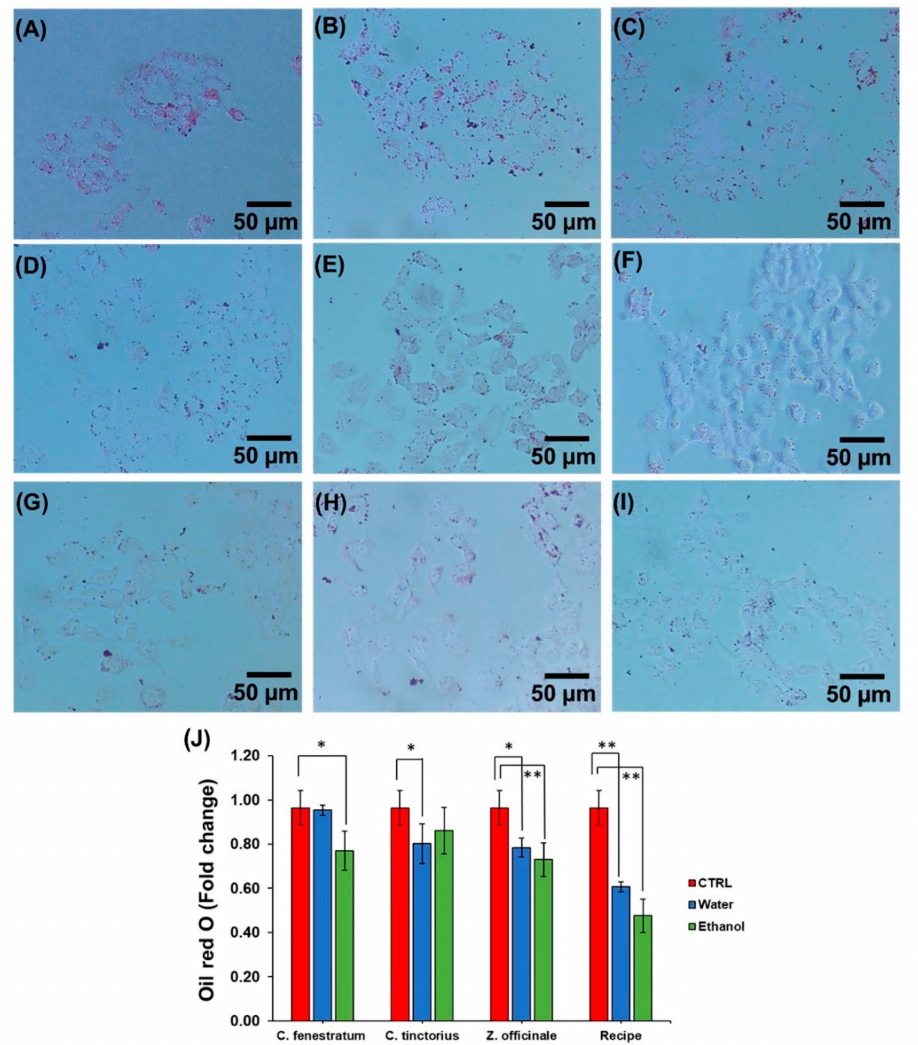
Figure 3. Effects of Oil red-O staining in HepG2 and examined using an inverted microscope. Oil red-O staining of HepG2 was incubated with water extract of ( B ) C. fenestratum , ( D ) C. tinctorius , ( F ) Z. officinale , and ( H ) recipe and Ethanolic extract of ( C ) C. fenestratum , ( E ) C. tinctorius , ( G ) Z. officinale , and ( I ) recipe compared to without treatment as ( A ) control. ( J ) Quantification of lipid accumulation by extracting oil red-O with isopropanol and measuring the OD of extract at 500